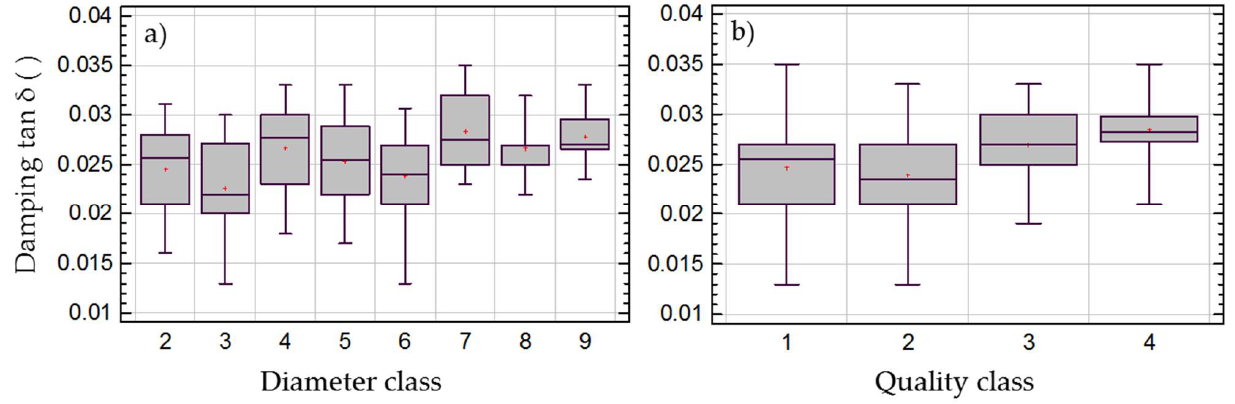
Figure 12. Distribution and interdependence between vibration damping (tan δ ) and the ( a ) diam- eter class of logs and ( b ) quality class (Q 1 –Q 4 ) of spruce